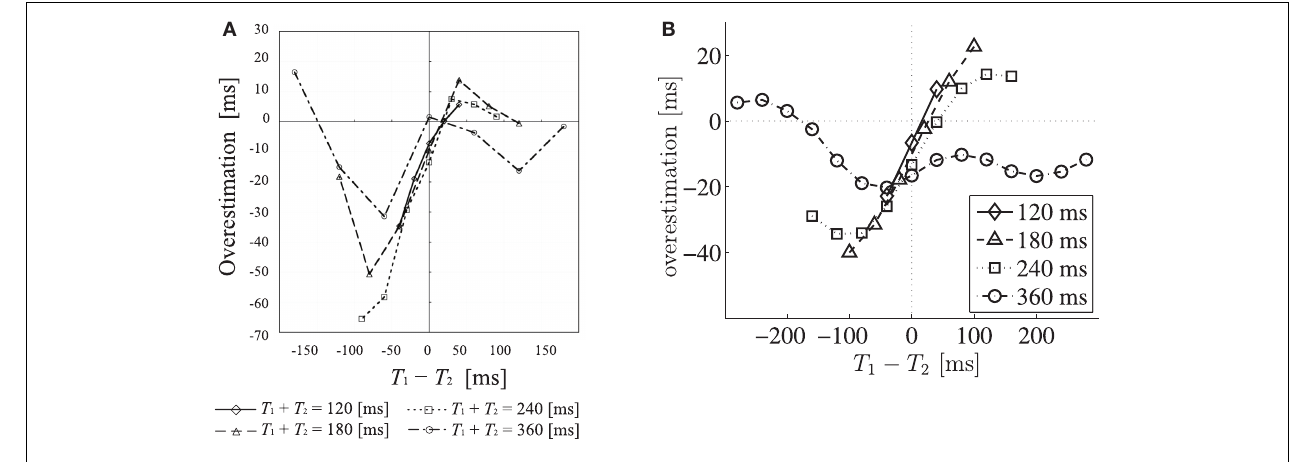
Press Journals. Adapted with permission.) (B) Simulated overestimation of T 2 , calculated by subtracting T 2 from the expectation value of P( T 2 | s 1 , s 2 , s 3 ).The area under the horizontal dashed line indicates the underestimation of T 2 , and the area on the left side of the vertical dashed line indicates T 1 < T 2